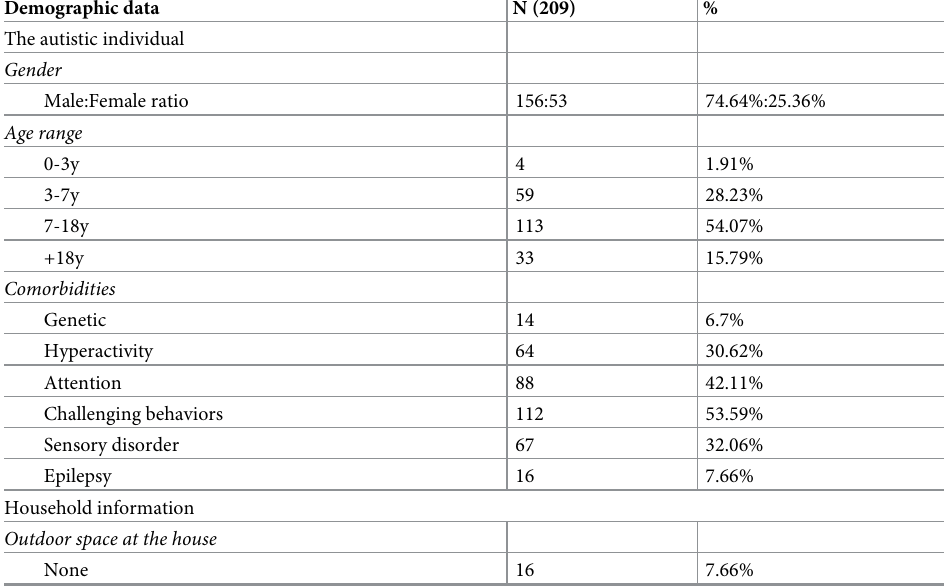
Table 1. Respondents’ descriptive